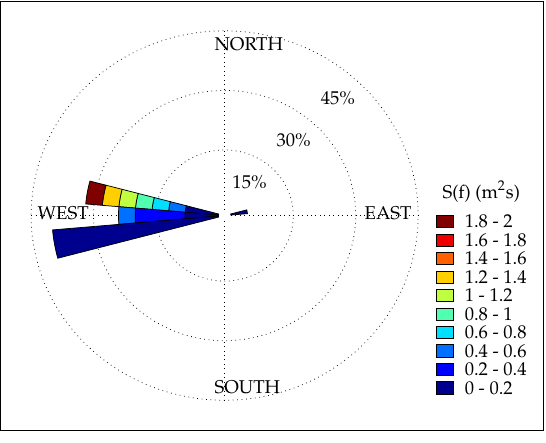
Figure 8. Wave rose of WAVEWATCH III output at location of input for NEWRANS model.